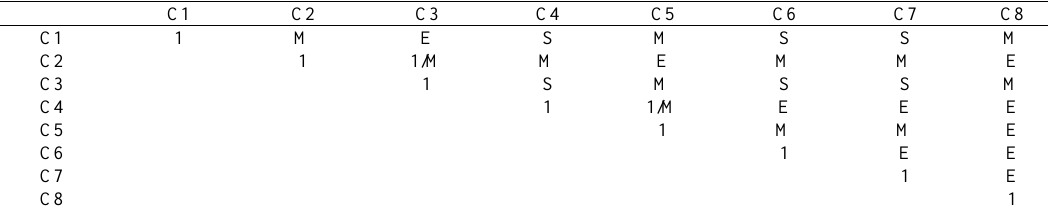
Table 3. The judgments of expert 1